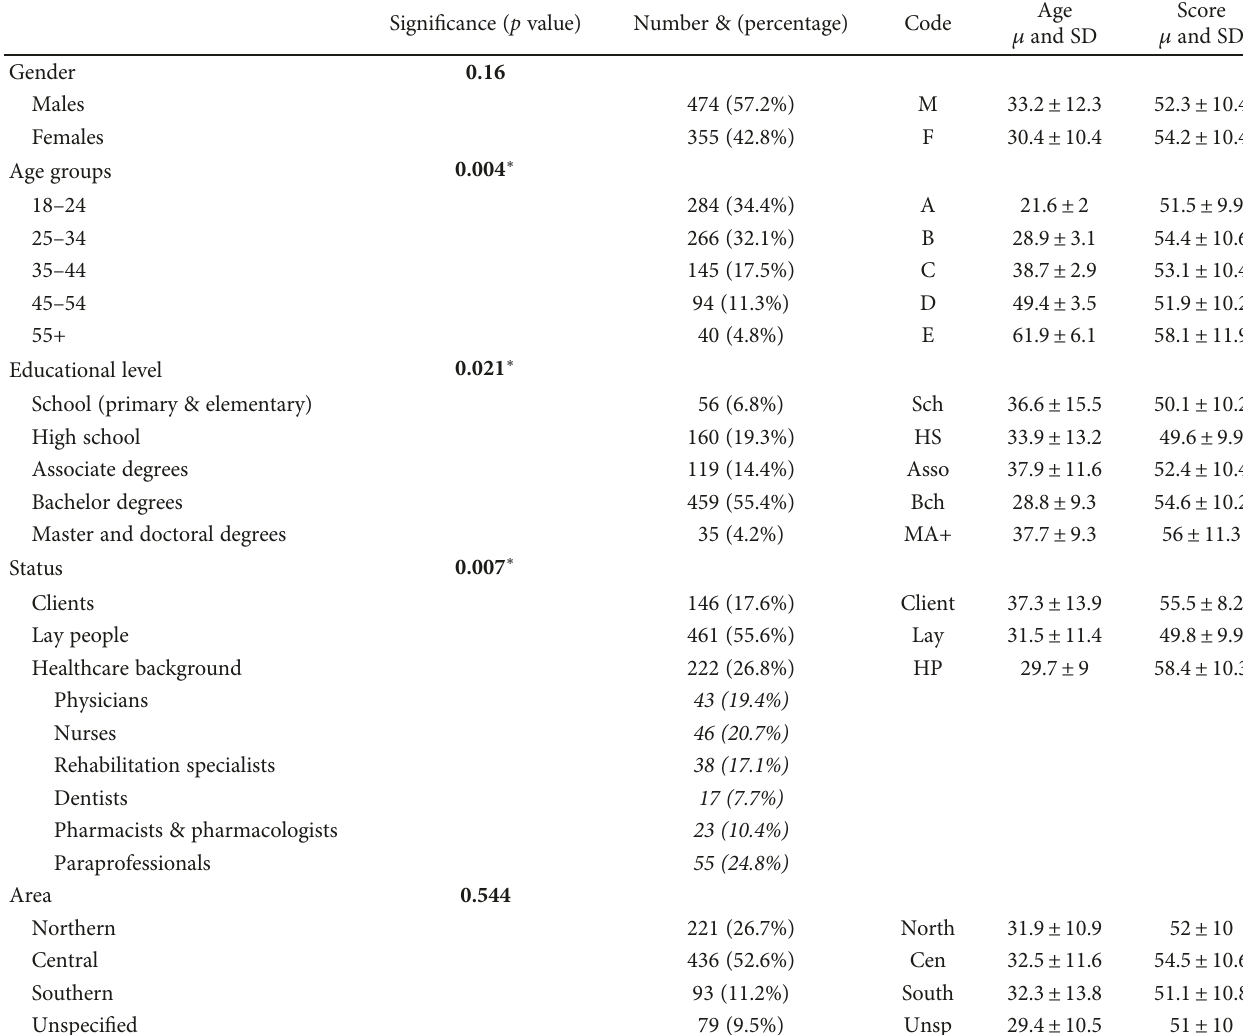
Table 1: Mean scores and SD of subgroups and p